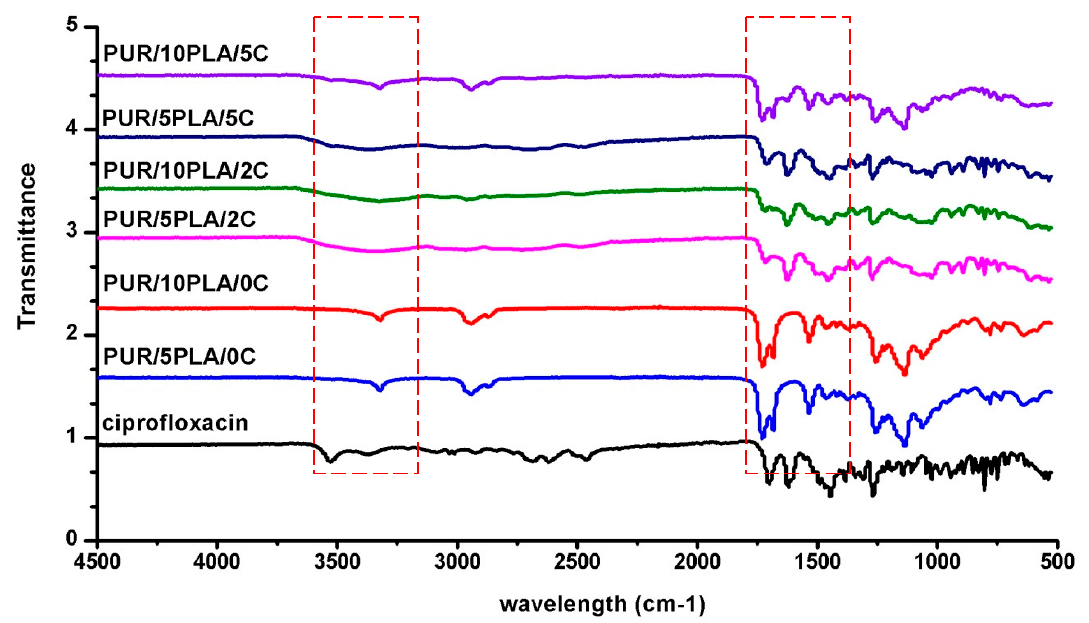
Figure 1. The FTIR spectra of ciprofloxacin used for HPPS modification and FTIR spectra